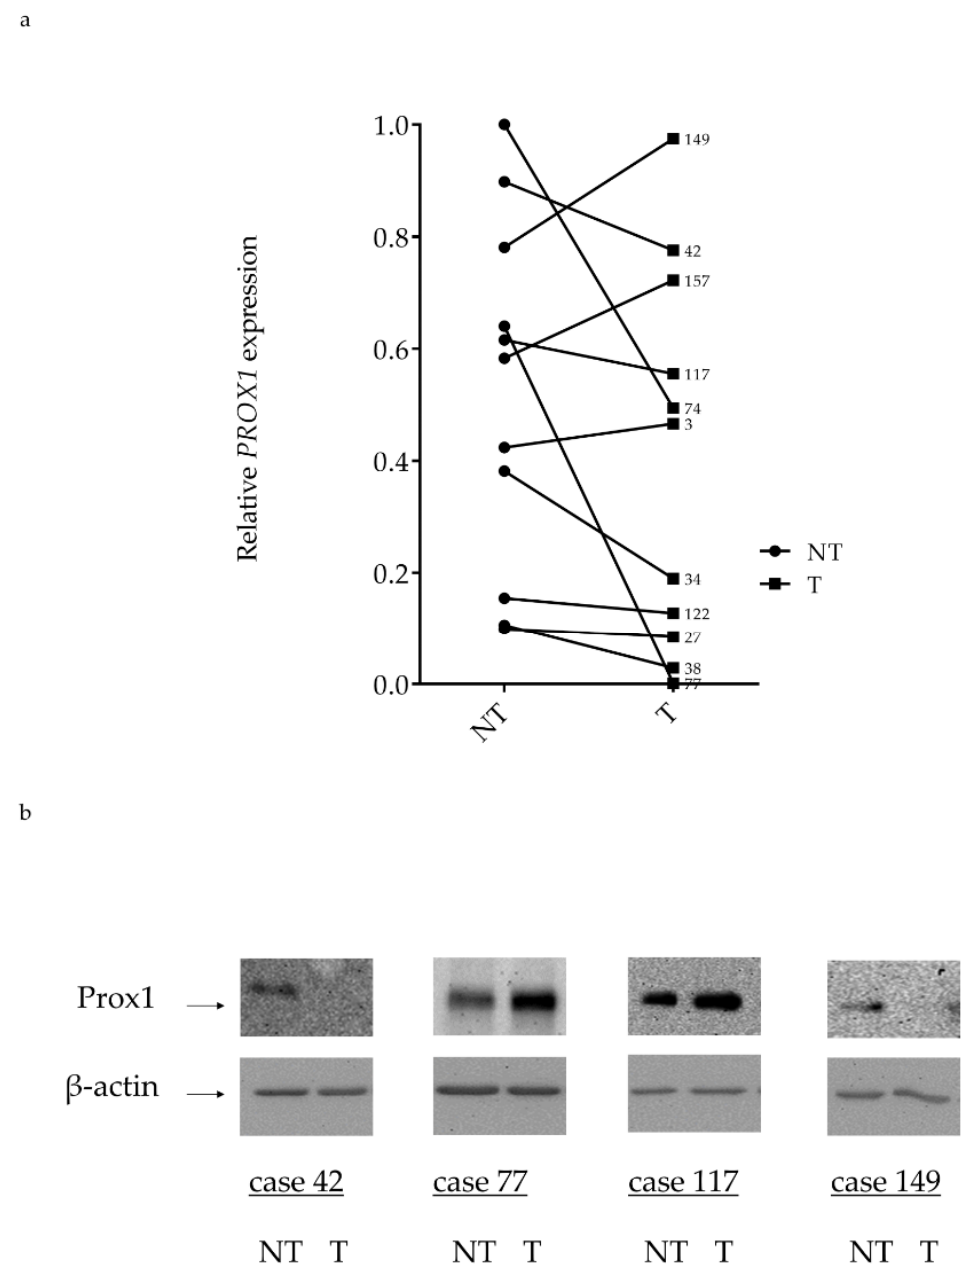
Figure 7. The expression of PROX1 was examined in human follicular thyroid cancer and non-cancerous tissues by RT-qPCR and Western blot and shows variability without correlation with protein expression level. ( a ) Relative PROX1 mRNA expression in 11 FTCs (T) and paired non-tumoral tissues (NT) analysed by RT-qPCR. PROX1 expression level is reported as Ct values normalized to corresponding Ct values of the housekeeping gene (ACTB). ( b ) PROX1 protein was evaluated in selected human FTCs cases and non-tumoral paired control tissues using Western blotting with anti-Prox1 antibody and β -actin as a loading control.